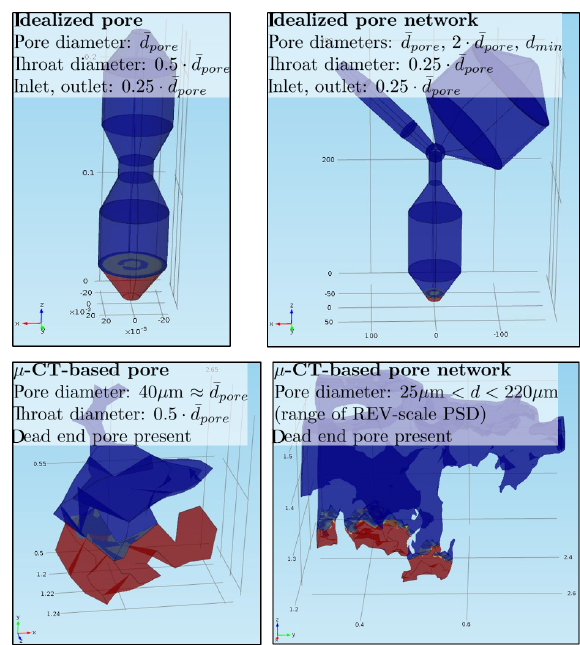
Figure 8. Heletz sandstone digital sample approximation based on idealized and µ -CT-based model domains used within this study. All domains are visualized at initial condition. Blue colours rep- resent water, red colours CO 2 . The orientation grid is given inµm scale for the idealized pore network domain and for all other do- mains in millimetres.